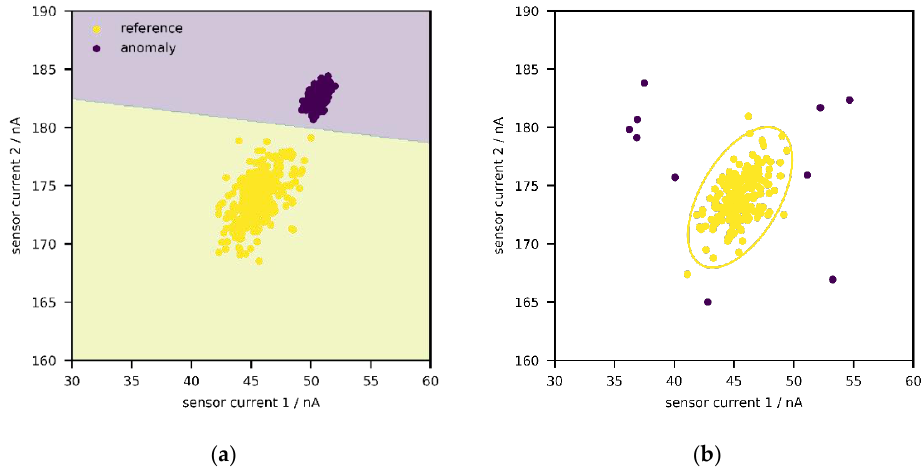
Figure 1. Distribution of sensor currents for a system consisting of two sensors. ( a ) Classification of anomalies in signal space with supervised anomaly detection. ( b ) Classification of anomalies in signal space with unsupervised anomaly